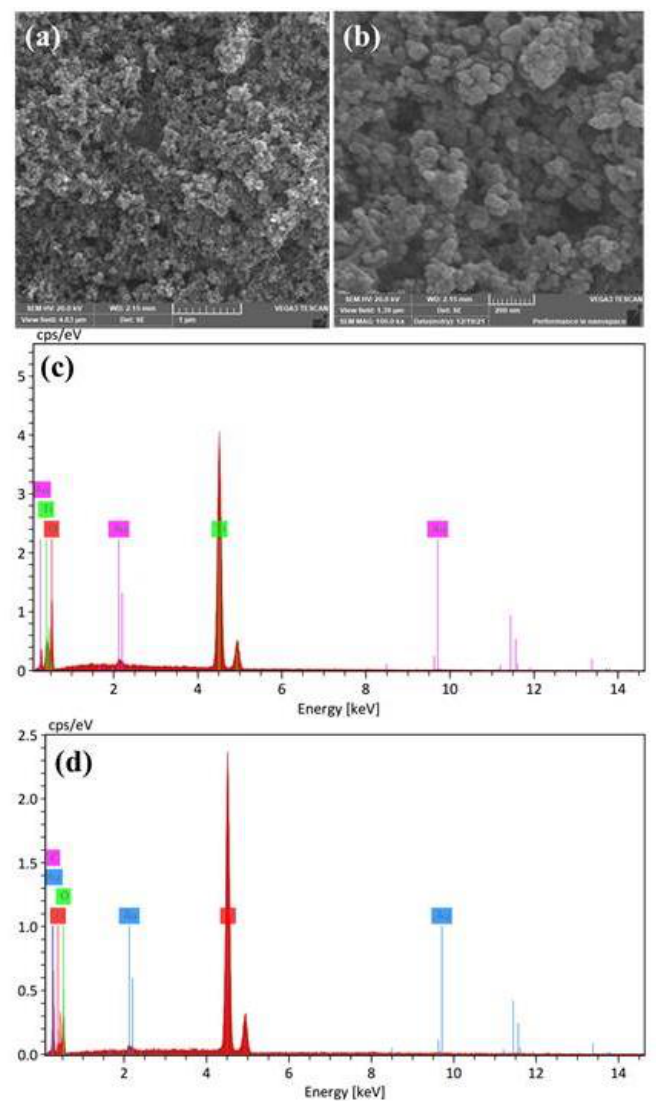
Figure 6. SEM images of Au@TiO 2 material (Au = 8.14%) at different magnifications; ( a ) 30 kx and ( b ) 100 kx. ( c , d ) EDX profiles for Au@TiO 2 and Au@TiO 2 /MWCNT materials confirming the presence of elements as expected.